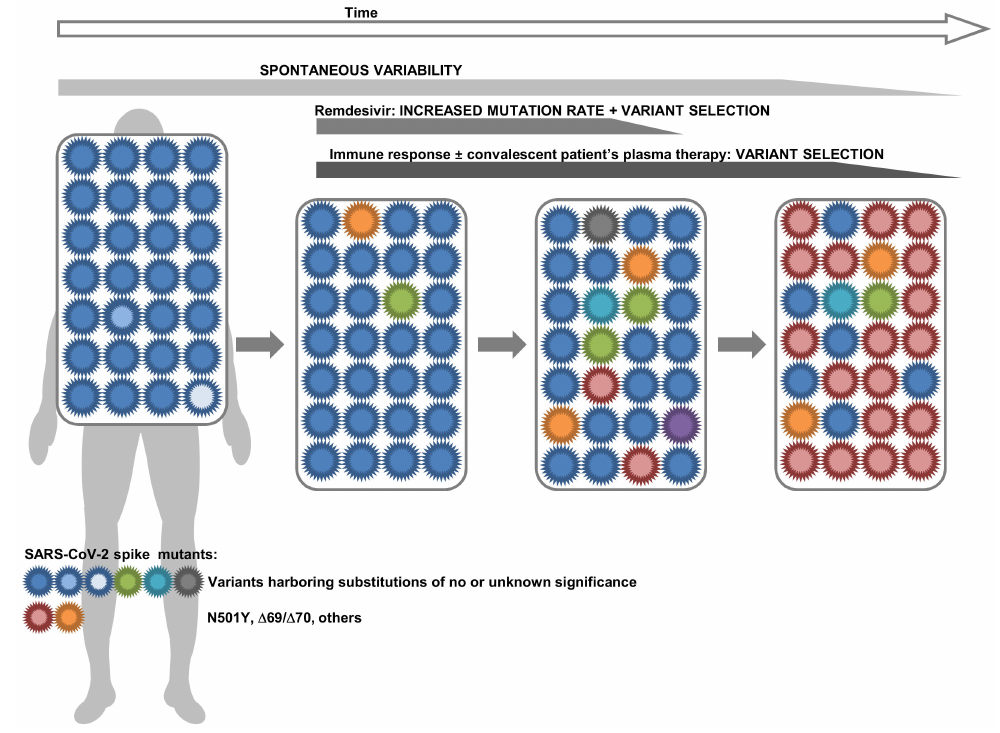
Figure 2. Possible mechanism of occurrence and selection of SARS-CoV-2 spike